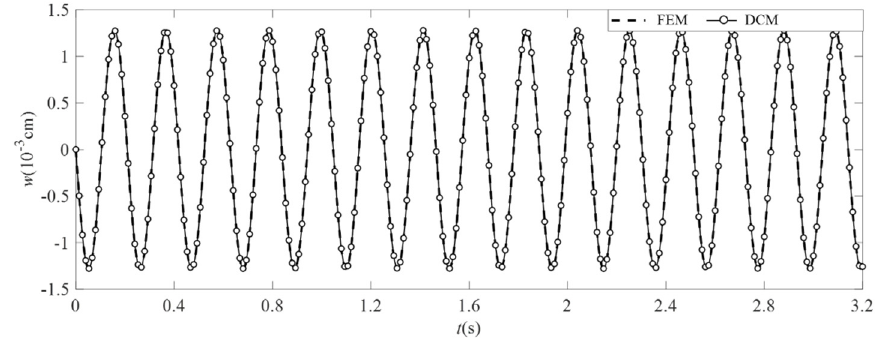
Figure 13. DC solution and finite element solution of time-history displacement of the center point ( T = 3.2 s, FEM ∆ T = 0.01